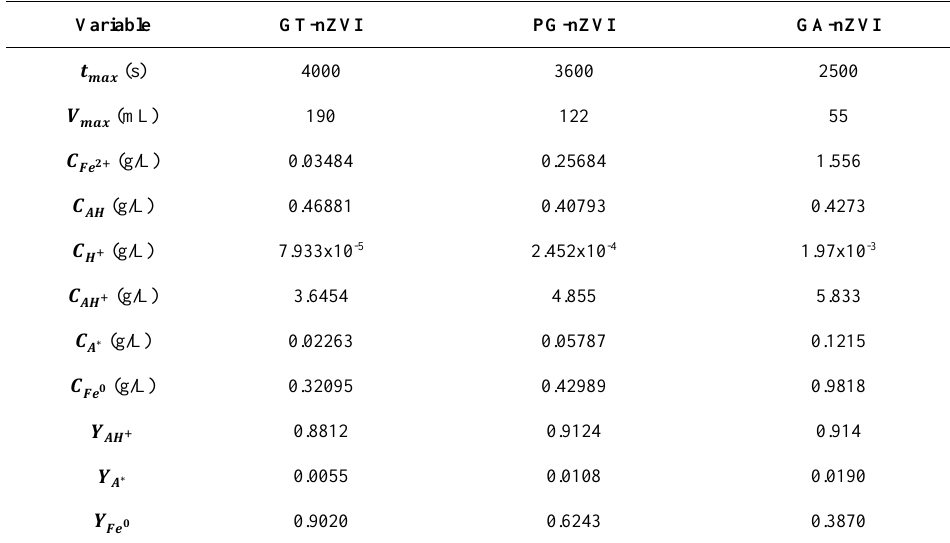
Table 5. Final component concentrations and yield (Yi) of ZVI synthesis.